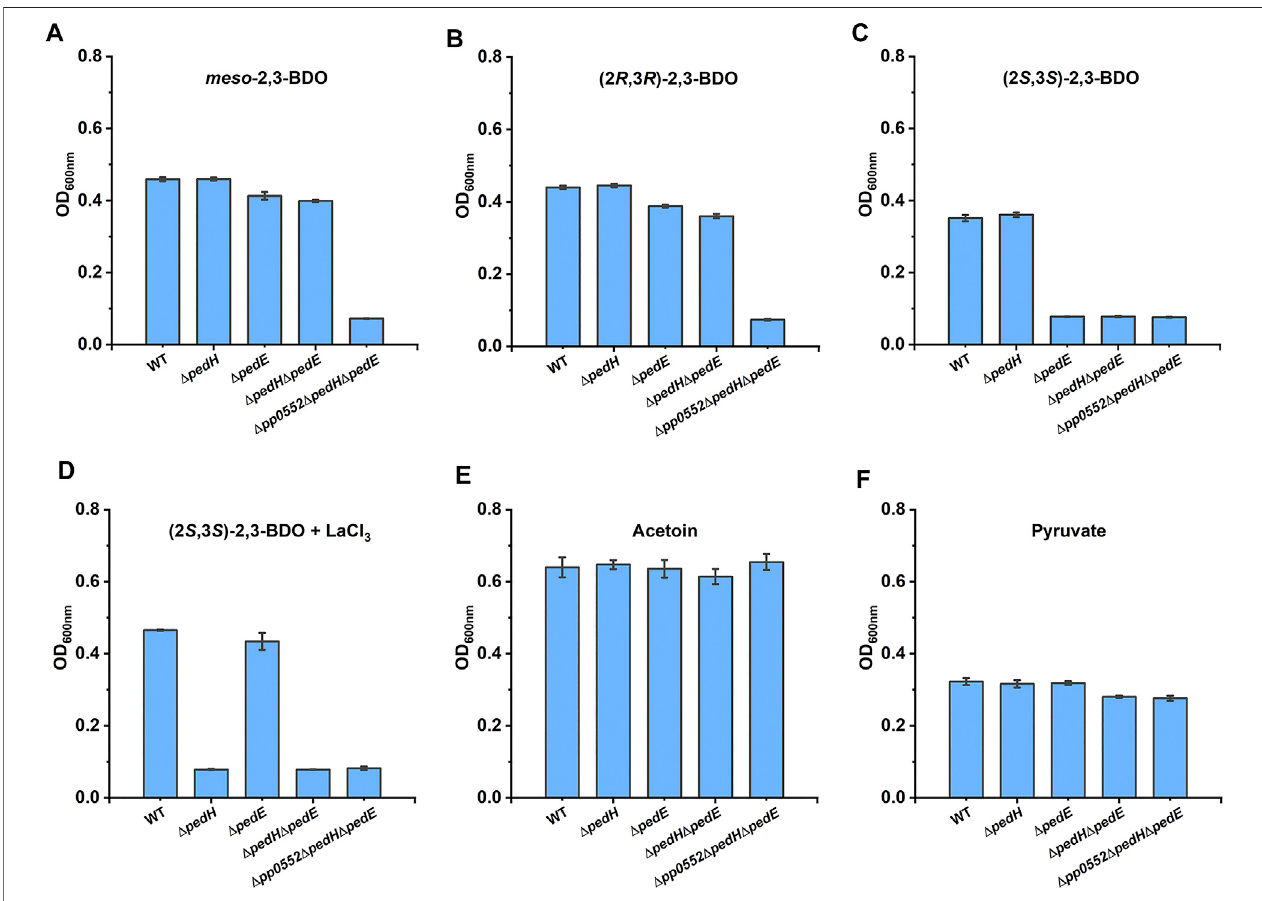
FIGURE5| Identi fi cationofthephysiologicalfunctionofPedEandPedHin2,3-BDOcatabolism.Individualandcombinatorialdeletionmutantsof P.putida KT2440 werecultured in MSM supplemented with2 g L − 1 meso -2,3-BDO (A) , (2 R ,3 R )-2,3-BDO (B) , (2 S ,3 S )-2,3-BDO (C) , (2 S ,3 S )-2,3-BDO with 20 μ MLaCl 3 (D) , racemic AC (E) and pyruvate (F) as the sole carbon source at 30 ° C for 30 h by using a Bioscreen microbiology reader. Error bars indicate deviation from the means ( n (cid:2) 3).